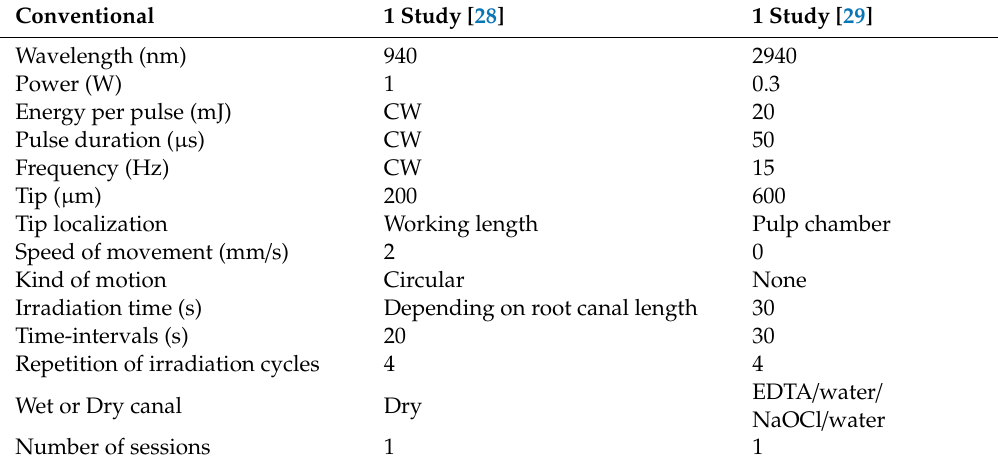
Table 5. Parameters used in conventional laser endodontics.